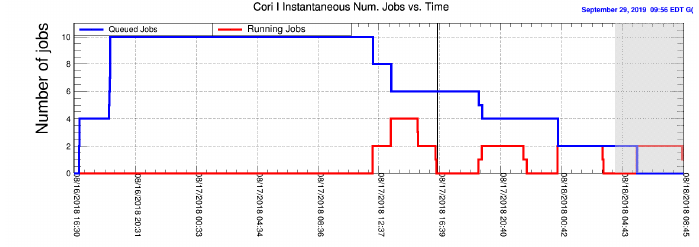
Figure 5. Jobs from short 10 job test using Cori I (haswell). Blue: Jobs queued in the slurm system at NERSC, but no yet running. Red: Number of running